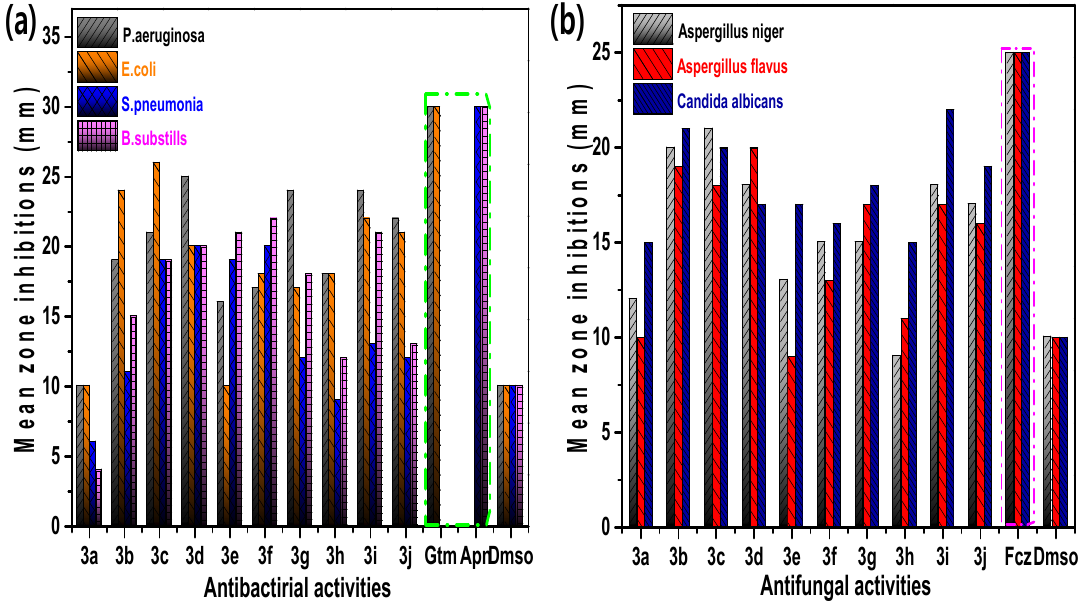
Figure 4. The antibacterial ( a ) and antifungal ( b ) activities of aryl benzimidazole derivatives.